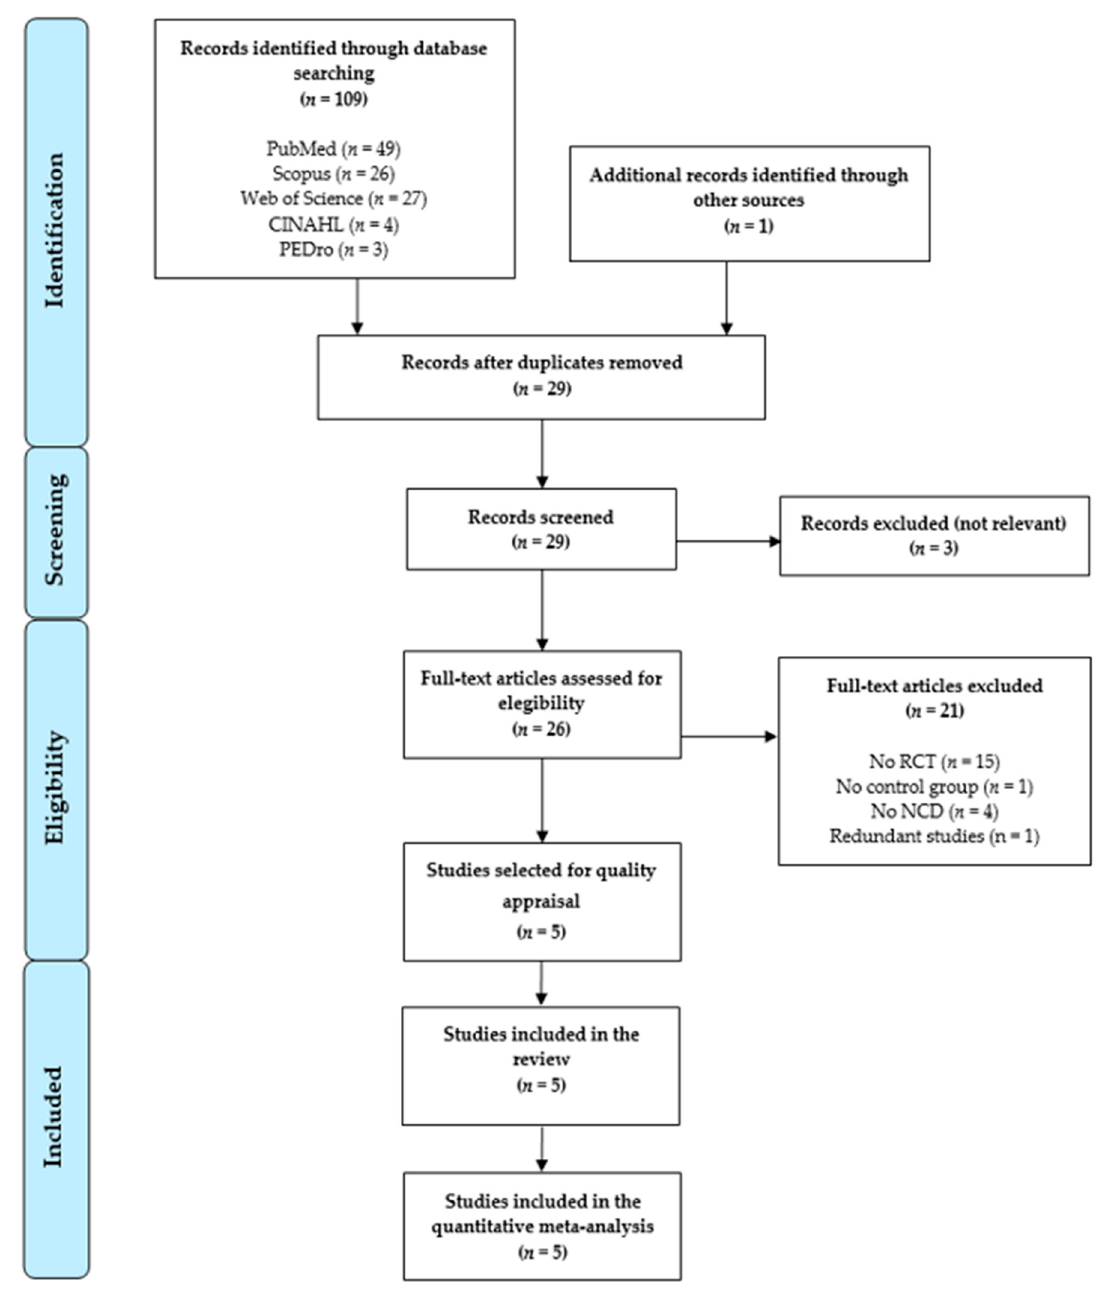
Figure 1. Preferred reporting items for systematic reviews and meta-analysis (PRISMA) flow chart.